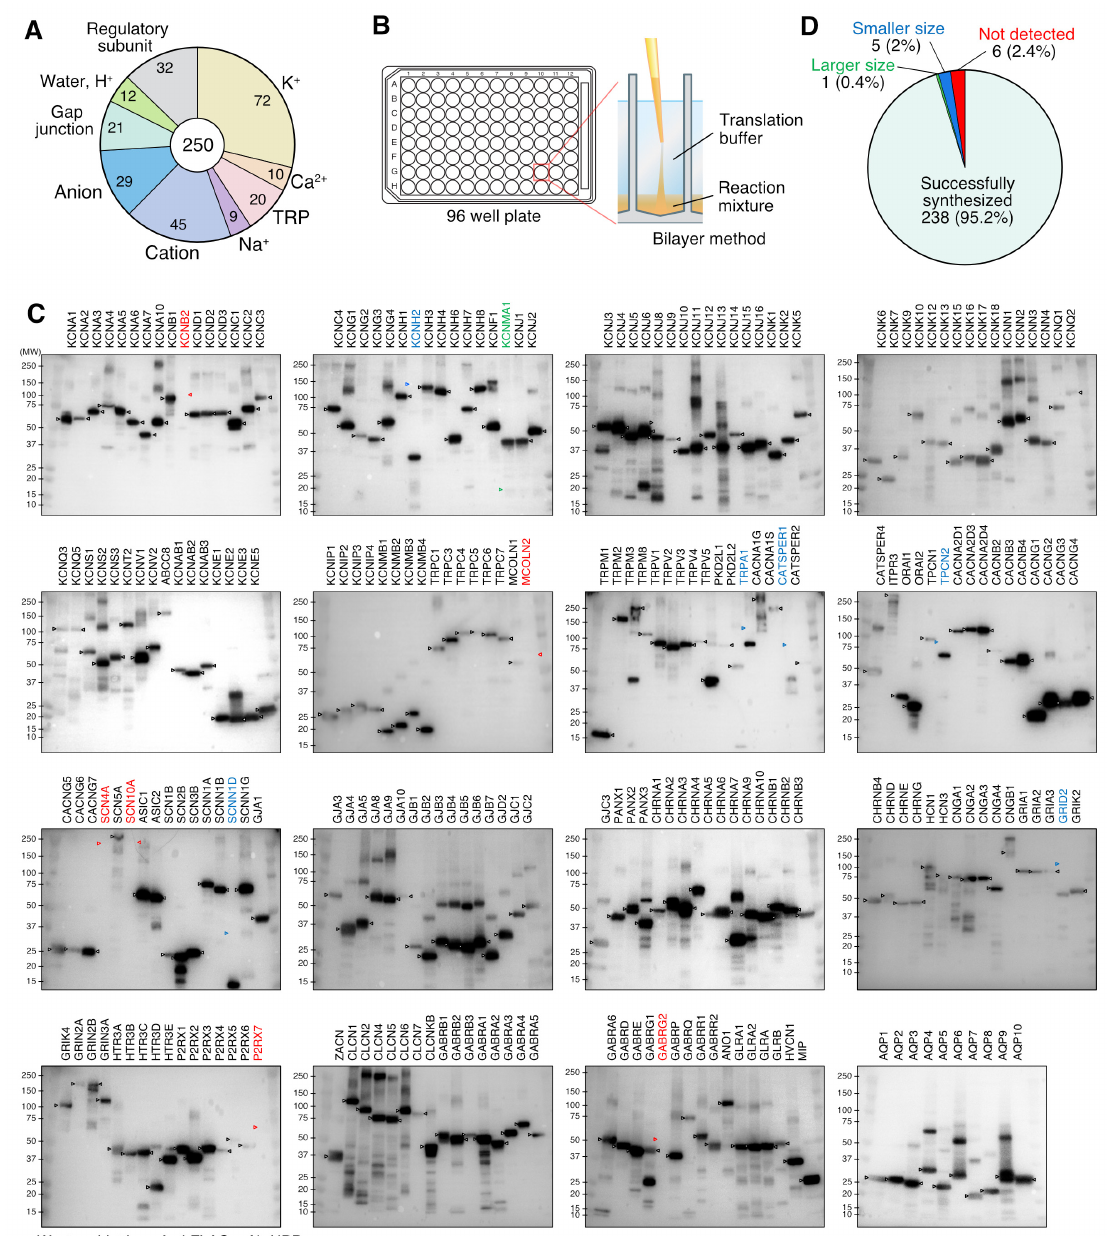
Figure 3. Cell-free synthesis of 250 human channels. ( A ) Composition of human channels synthesized in this study. ( B ) Illustration of bilayer method in 96-well plate. ( C ) Western blotting image of cell-free synthesized human channels. FLAG-tagged channels were detected by horseradish peroxidase- conjugated anti-FLAG antibody. Channels with names in black were well synthesized. Black arrowheads indicate bands of synthesized channels. Channels named in red have no polypeptide detected, where red arrowheads show the predicted mobility of the channels. Channels named in blue had bands of smaller size than expected (blue arrowheads). Channel in green had bands of larger size than expected (green arrowhead). ( D ) Summary of Western blotting